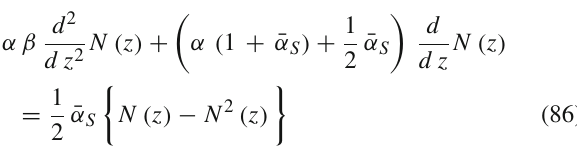
Fig. 7 N (cid:5) z / N and N forthesemiclassicalsolutionofEq.(75)areshown in green, while in red we show the values of N (cid:5) z / N for the solution of Eq. (71) for small